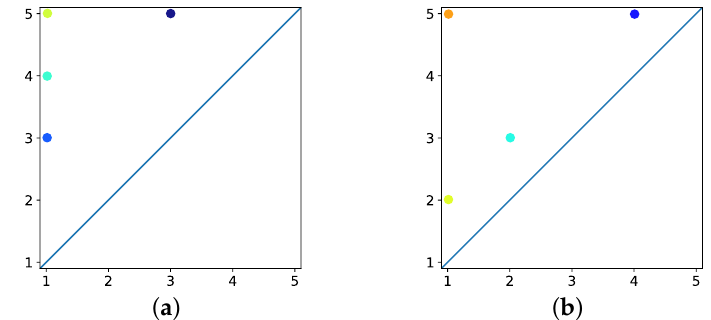
Figure 12. The robust tracking of objects in a sequence of four rain radar images is illustrated. The objects in question correspond to spatially close connected components and are uniquely coloured.